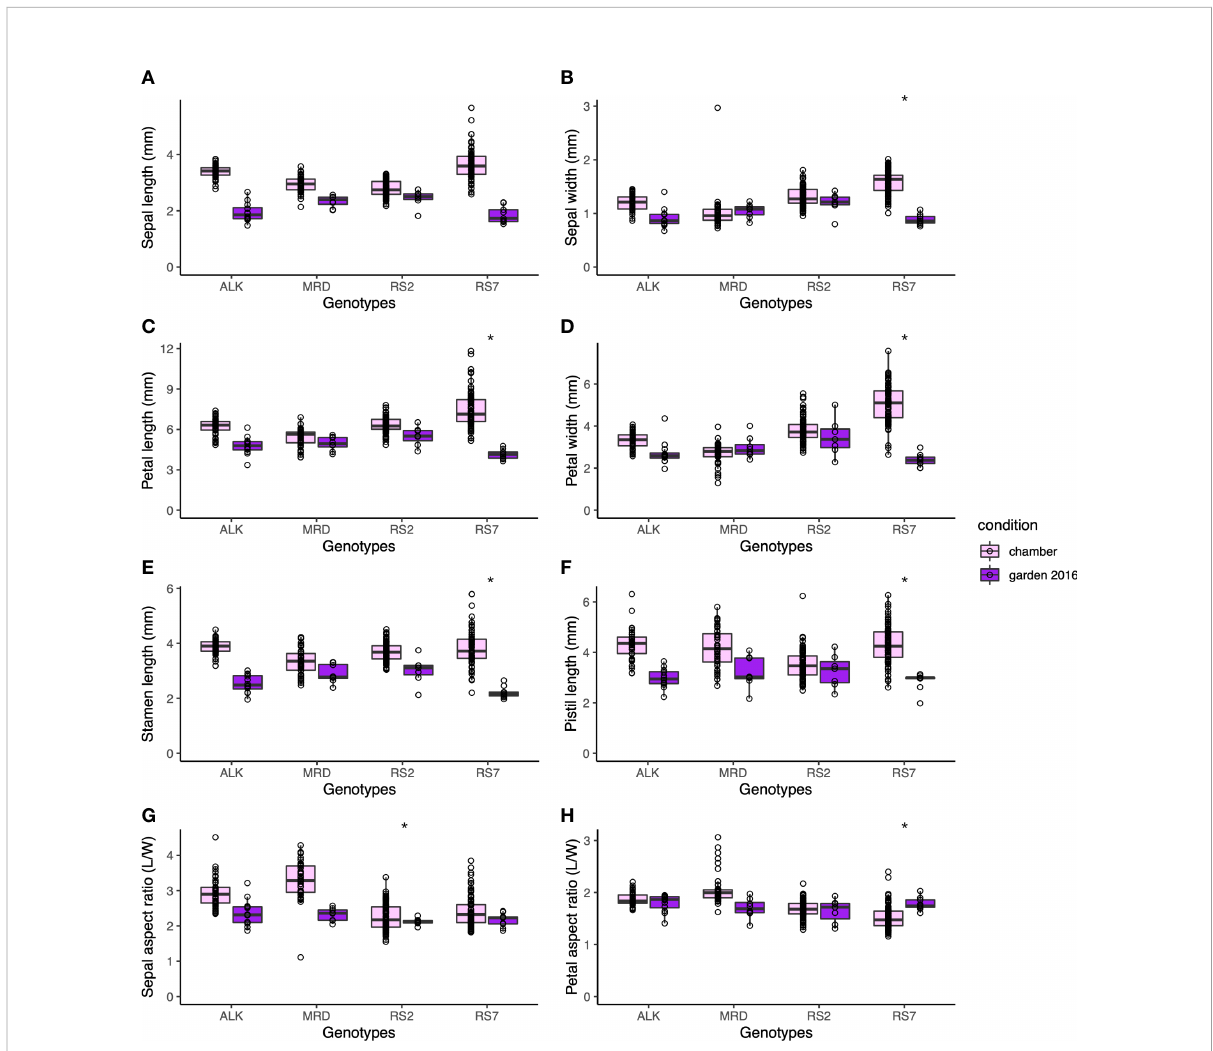
FIGURE 4 The traits representing the size and shape of fl oral organs. Sepal length (A) and width (B) . Petal length (C) and width (D) . (E) Stamen length. (F) Pistil length. (G) Sepal aspect ratio, length divided by width. (H) Petal aspect ratio, length divided by width. The asterisk represents the P-value by Levene test (*: P<0.05; **: P<0.01; ***: P<0.001).